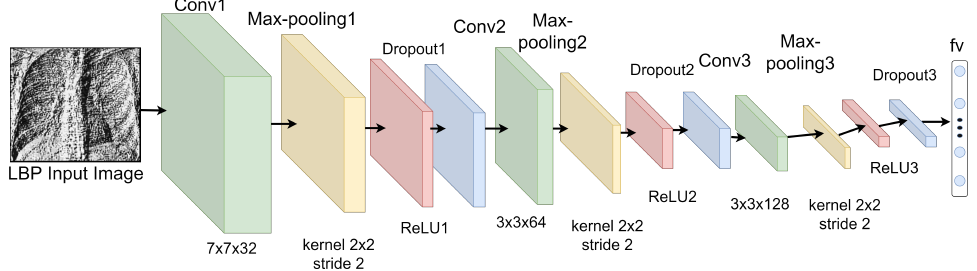
Figure 5. Shallow CNN structure applied for the feature extraction of LBP CXR